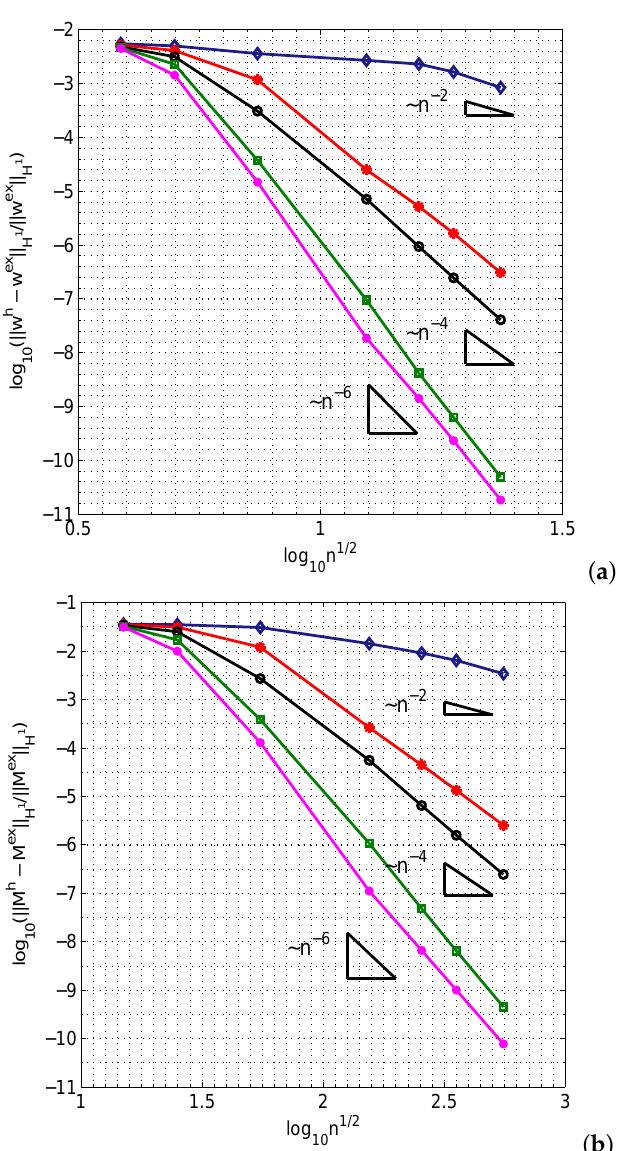
Figure 6. Cantilever cylindrical shell under tip load. Accuracy and convergence assessment for h − refinement and p − refinement. H 1 -norm relative error log − log plot for different on-Uniform Rational B-Spline (NURBS) interpolation order p and different discretization size n : ( a ) transverse tip displacement w ( 0 ) ; ( b ) shear force Q 11 ( 0 ) . blue diamonds - p = 3, red stars - p = 4, black circles - p = 5, green squares p = 6, magenta bullets p =